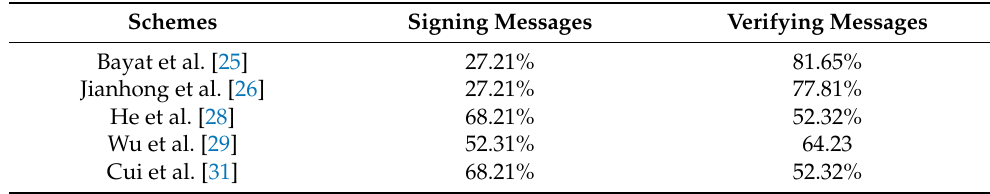
Table 5. Cost of computation comparison.